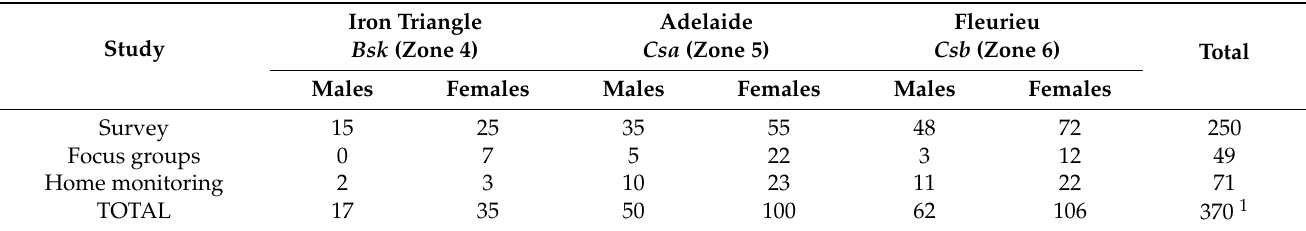
Table 1. Number and sex of participants in each stage of the study in the three